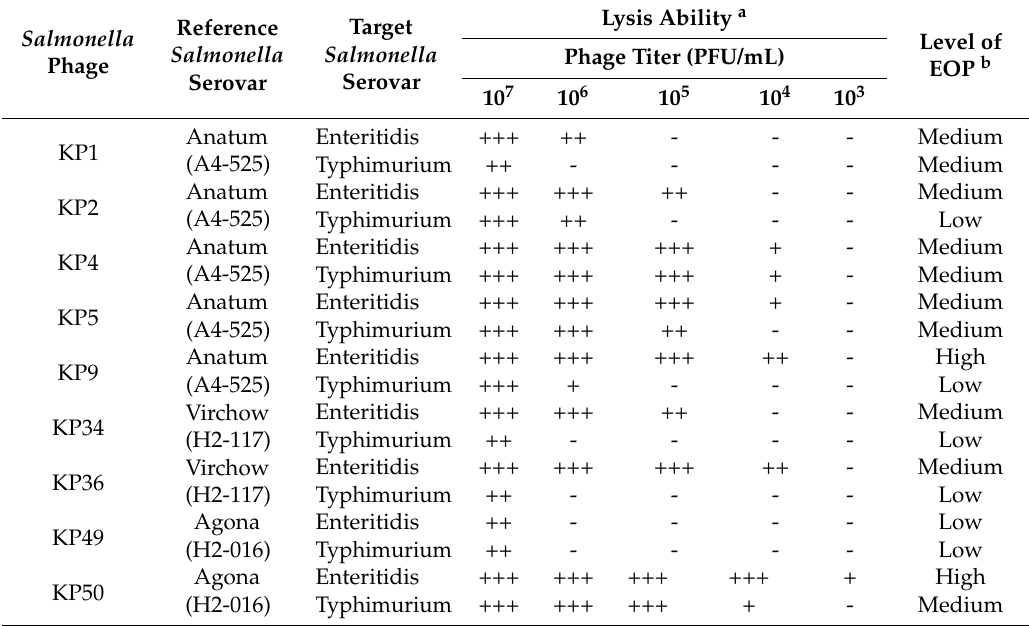
Table 5. Lysis ability and efficiency of plating (EOP) of Salmonella phages on S. Enteritidis and S. Typhimurium.